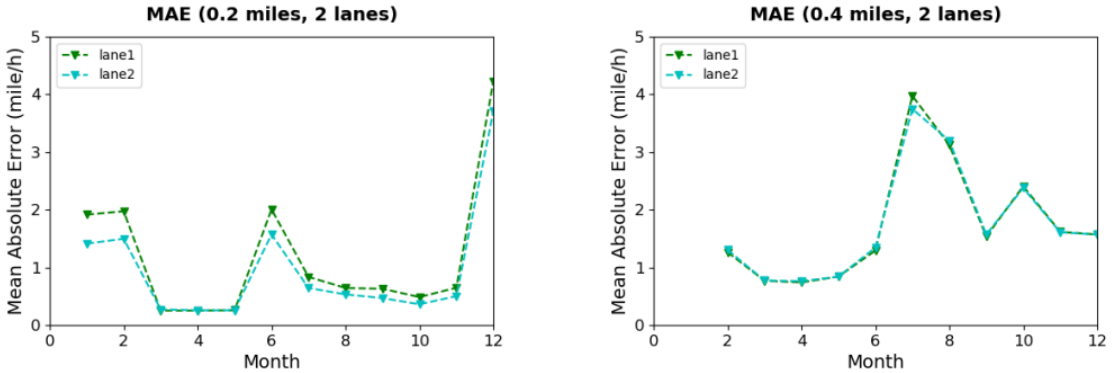
Figure 11. MAE curves of different lanes in two-lane